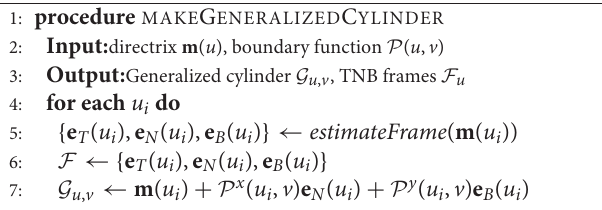
Algorithm 2 Generating GC with arbitrary